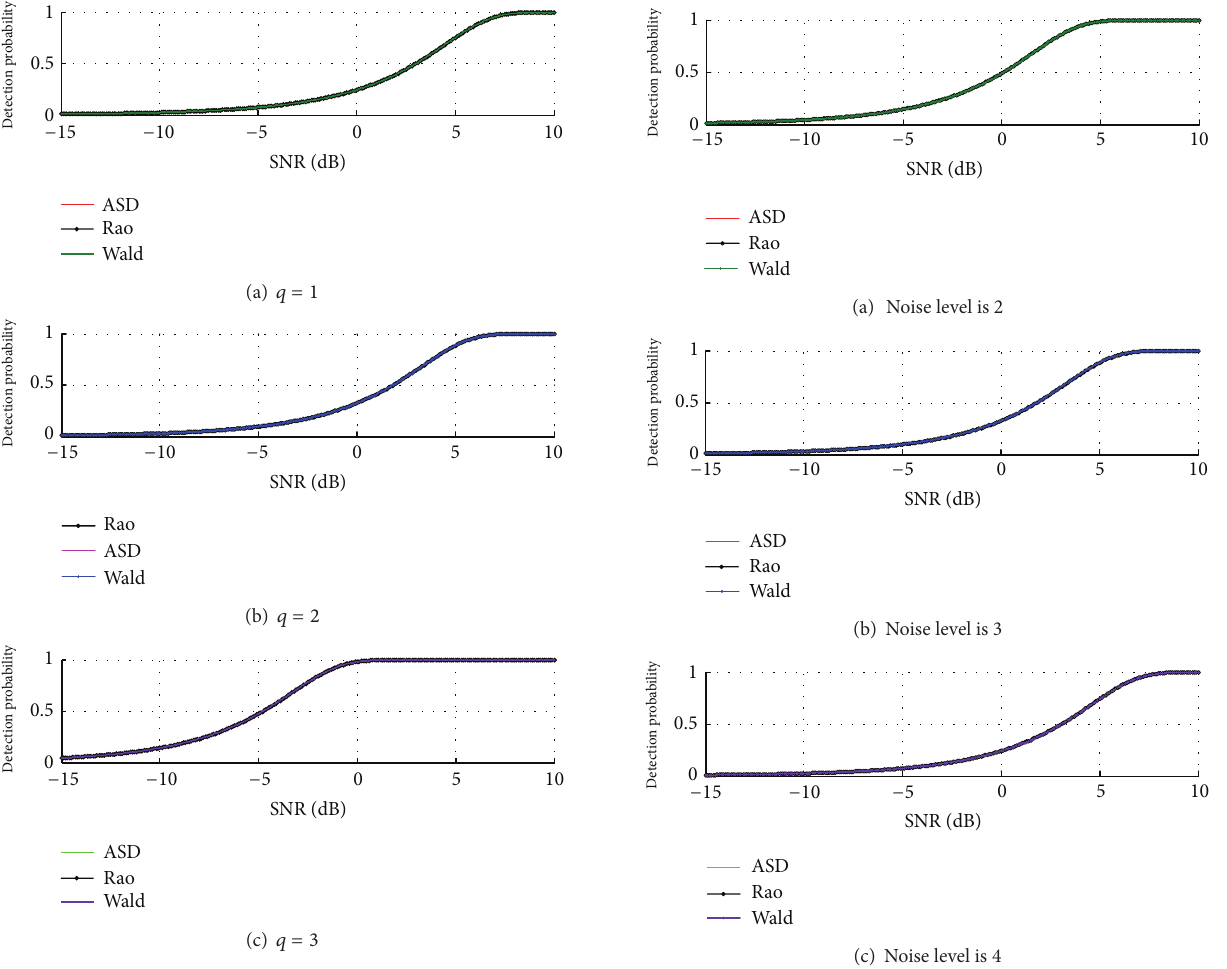
Figure 2: Detection performances of ASD, Rao test and Wald test with different polarimetric channels.